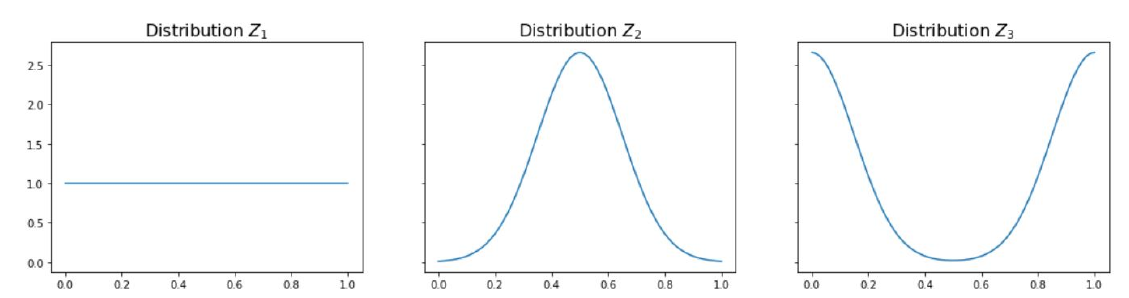
Figure 4. Examples of Z -distributions.